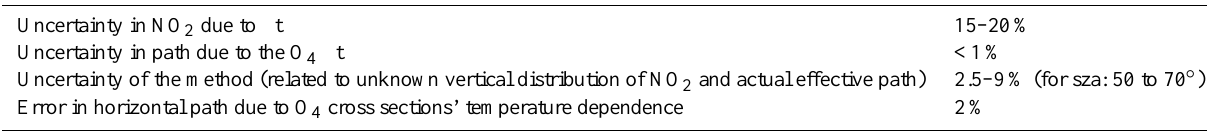
Table 1. Method uncertainty. Uncertainty in NO 2 due to